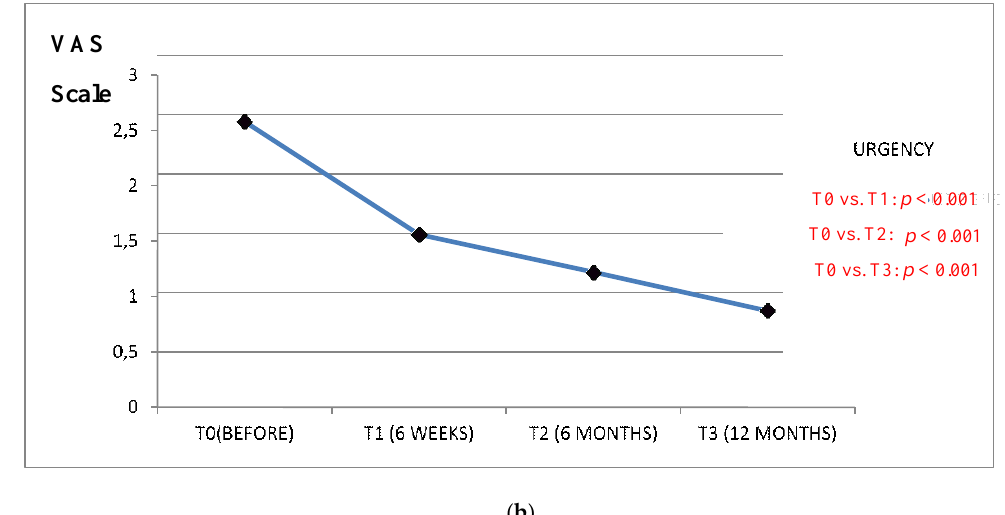
Figure 2. ( a ) Impact of the vaginal native tissue repair (VNTR) on urinary incontinence severity in everyday functioning—according to the visual analogue scale (VAS). ( b ) Impact of the vaginal native tissue repair (VNTR) on urgency severity in everyday functioning—according to the visual analogue scale (VAS).